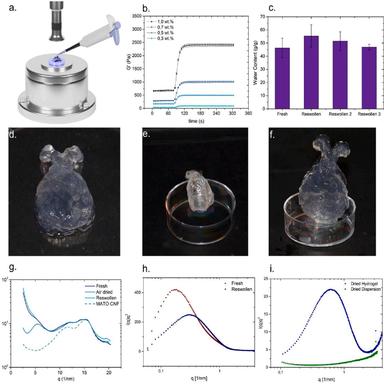
(a.) Artistic schematic of the photo-rheology experiments (b.) Development of storage modulus G' during photo-crosslinking at different MATO CNF concentrations (c.) Reswelling capacity of C-x networks (d-f) C-x network in the shape of a pineapple freshly made, air dried and reswollen in water (g.) Effect of drying/ reswelling cycles observed with WAXS and (h. and i.) Kratky plots from the SAXS measurements.